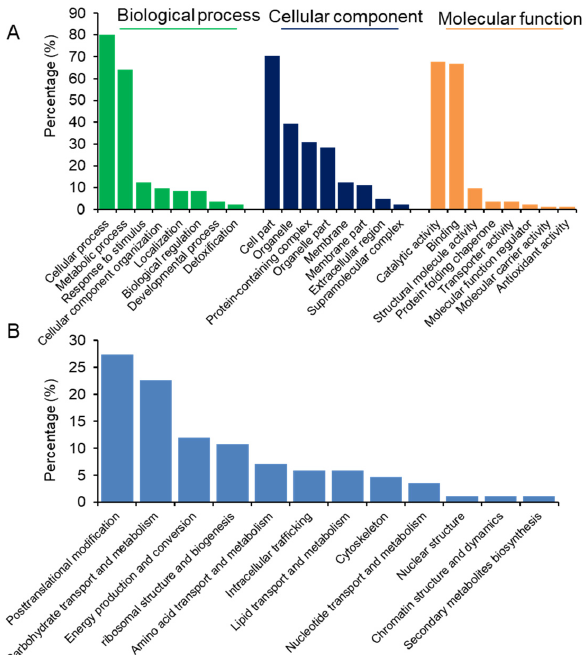
Figure 3. Functional analysis of significantly changed proteins between the seeds of X. aethiopica from Ghana and Nigeria. ( A ) Functional categorization of significantly changed proteins was analyzed using GO database with blast2go v4.5 pipeline software. ( B ) The molecular function of significantly changed proteins was analyzed using Clusters of Orthologous Groups of Proteins System (COG, http://www.ncbi.nlm.nih.gov/COG/).